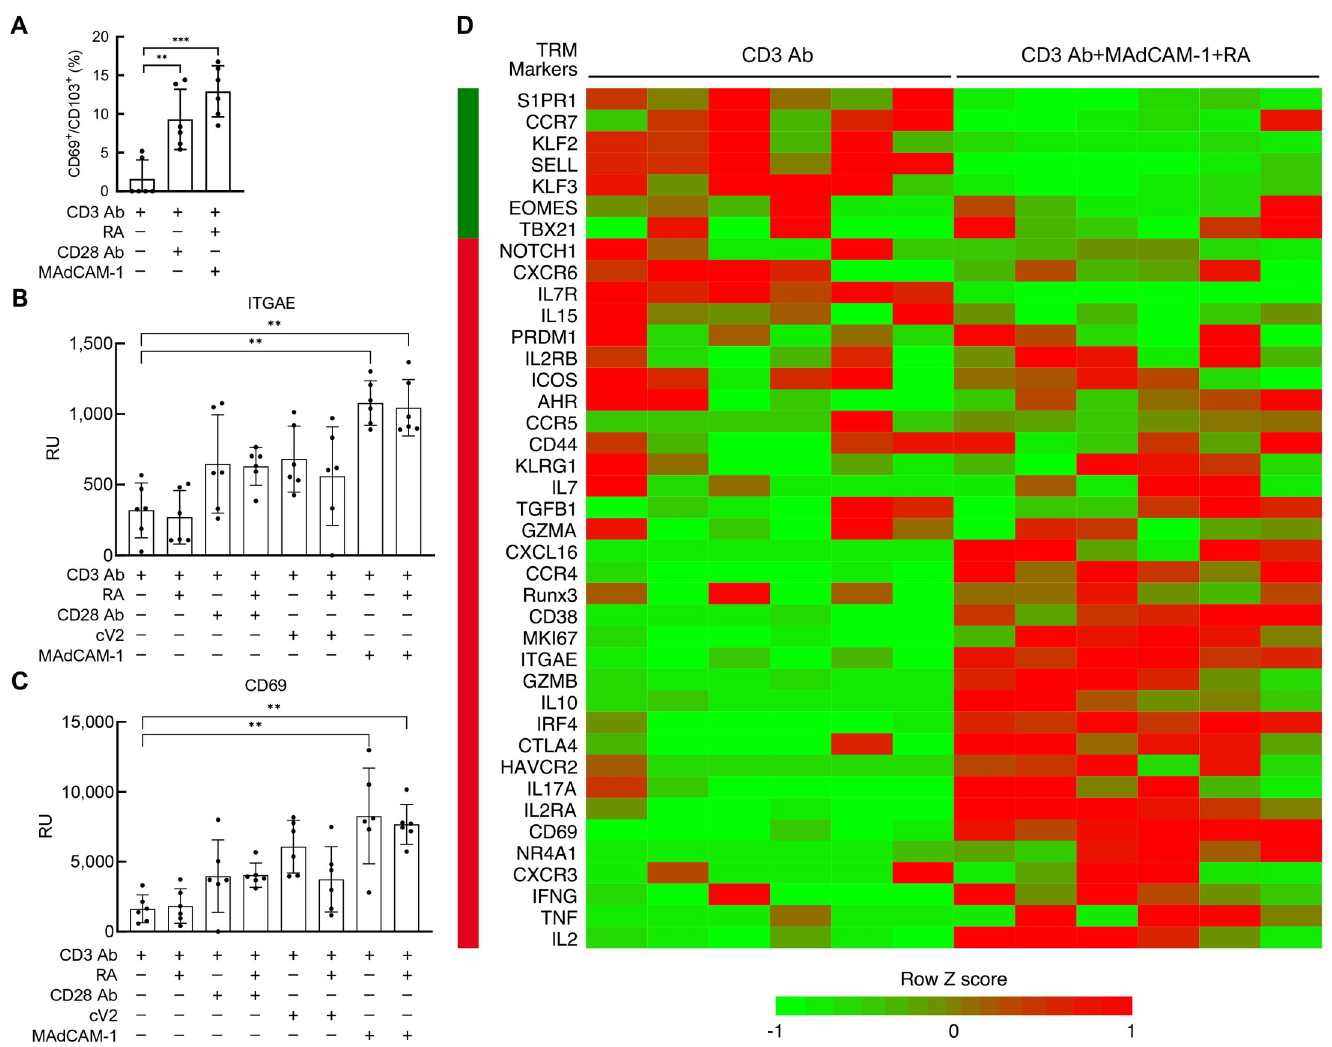
Fig 1. Transcription profile of MAdCAM-1 costimulated CD4 + T cells. ( A ) % CD69 + /CD103 + composition in bulk RNA-Seq samples stimulated with CD3 Ab, CD3 Ab + CD28 Ab, and CD3 Ab + MAdCAM-1 + RA as estimated by CIBERSORT. Average ( B ) ITGAE and ( C ) CD69 RNA levels from CD4 + T cells of 6 donors costimulated with CD3 Ab alone, CD3 Ab + cV2, CD3 Ab + MAdCAM-1, and CD3 Ab + CD28 Ab in the presence or absence of RA, detected by RNA-Seq. Y-axis represents relative units. Error bars indicate SD. ( D ) Heatmap comparing average RNA expression levels from 6 donors for 40 selected genes associated with T RM cells following stimulation with CD3 Ab vs CD3 Ab + MAdCAM-1 + RA. Each column represents one donor, each row represents a selected gene. Side bar indicates direction of gene modulation (green: decrease, red: increase) in T RM s, as previously reported. ( � : P < 0.05, �� : P < 0.01, ��� : P < 0.001 two-tailed t test).